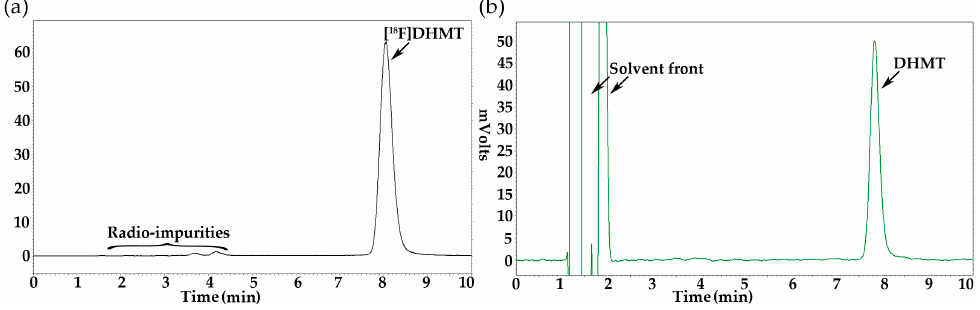
Figure 2. Analytical HPLC chromatograms for [ 18 F]DHMT: ( a ) radioactivity detection; ( b ) UV, with co-injection of [ 19 F]DHMT.